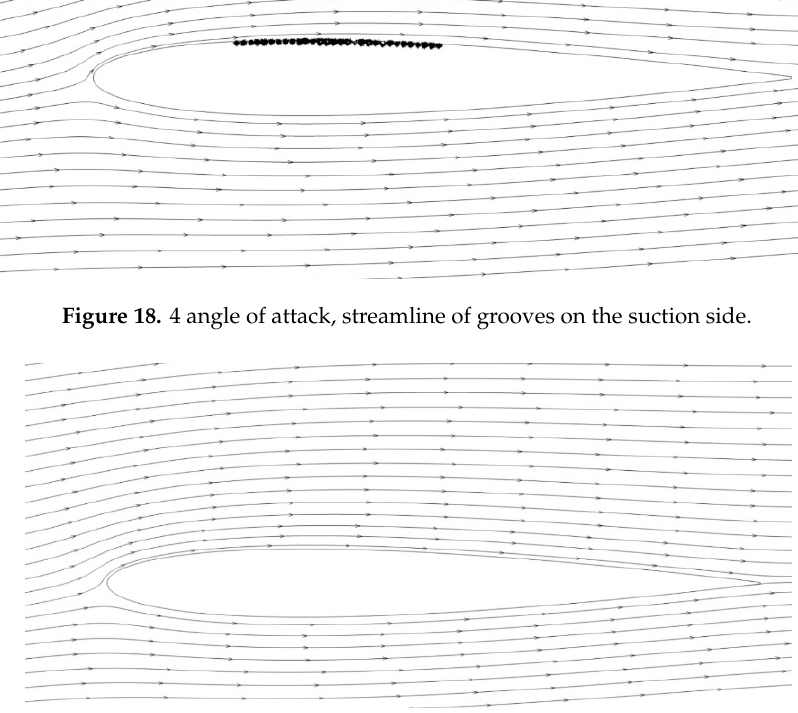
Figure 19. 4° angle of attack, streamline of standard NACA0012 airfoil.